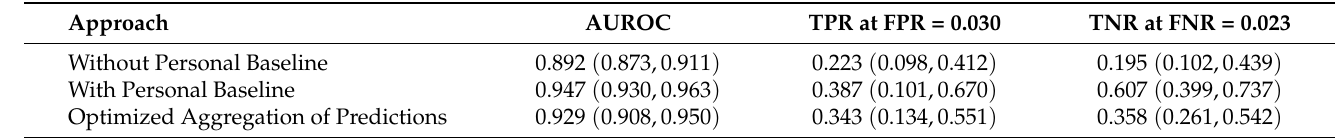
Figure 4. The mean and the standard error bands of the ROC curves of three different approaches for resuscitation sufficiency prediction. The False Positive Rate (FPR) and the False Negative Rate (FNR) are scaled logarithmically in the middle and right plots to emphasize the performance at the clinically relevant low prediction errors settings. Table 1. The mean and the standard error intervals of the AUC scores, True Positive Rate (TPR) at low False Positive Rate (FPR), and True Negative Rate (TNR) at low False Negative Rate (FNR) of three different approaches for resuscitation sufficiency